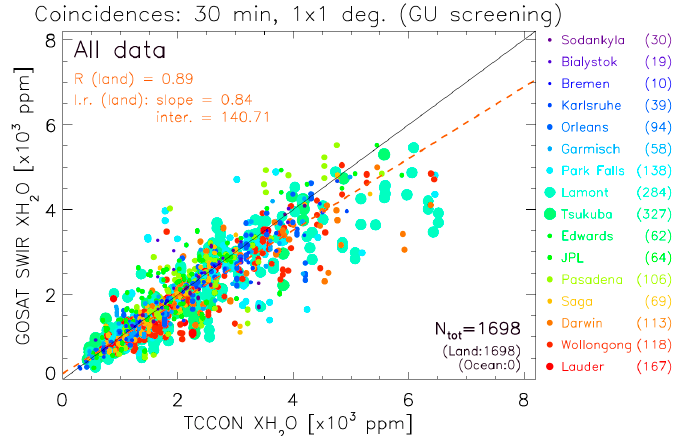
Figure 4. Scatter plot of the GOSAT TANSO-FTS XH 2 O and coincident TCCON soundings (criteria of ±30 min and ±1° in latitude/longitude). For these criteria, there are no coincident TANSO-FTS ocean scans. The caption and color-coding are identical to those of Figure 3.